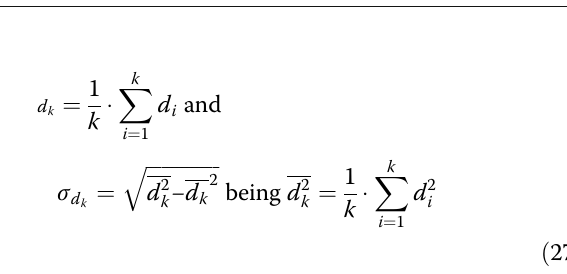
Fig. 2 Plot of the factor that relates the variance of the samples σ 2 and the variance of the second difference of the exponentially weighted r , as a function of β for different number of samples k (see Eq. moving average of the samples σ 2 d